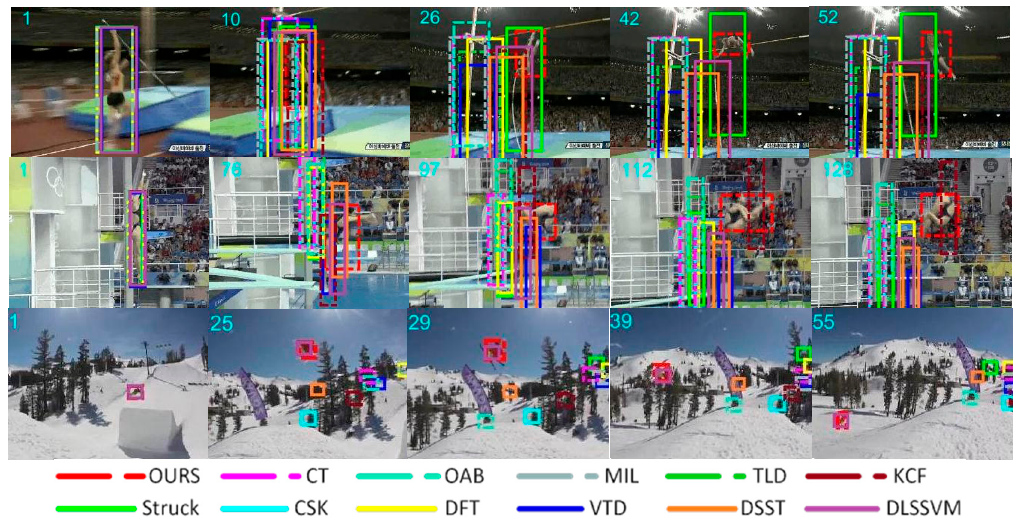
Figure 4. Tracking results of the proposed method and eleven state-of-the-art tracking methods on sequences Jump , Diving , and Skiing . In these sequences, there is a rotation problem.